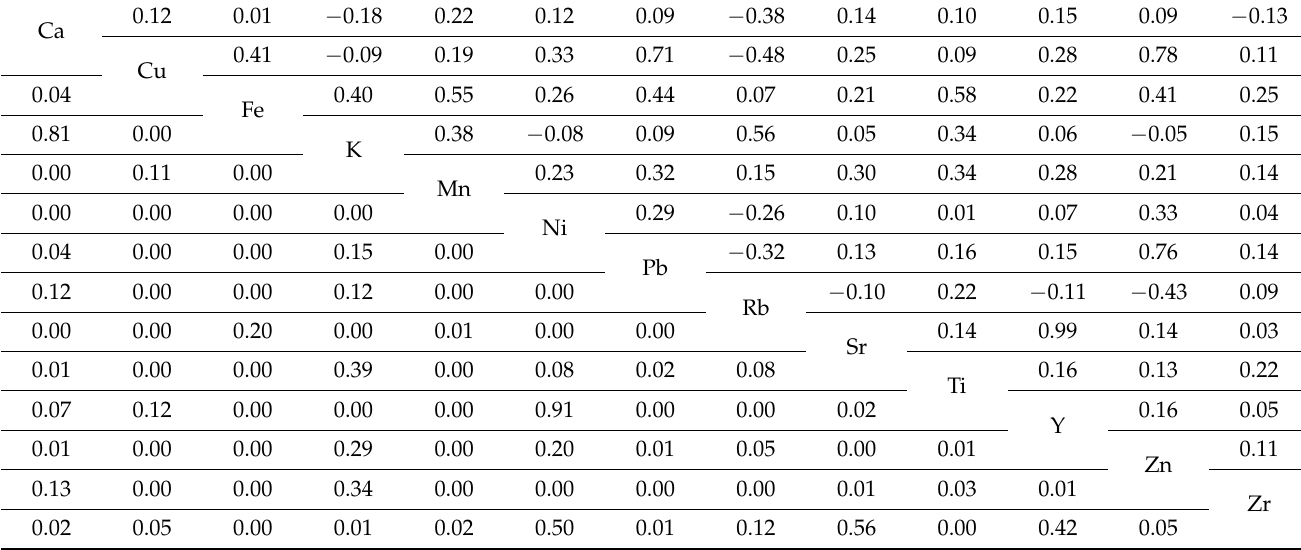
Table 2. Spearman correlation coefficients between elements (upper triangle) and p value (lower triangle). Coefficients greater than 0.4 are in bold, and significant p -values are in red.